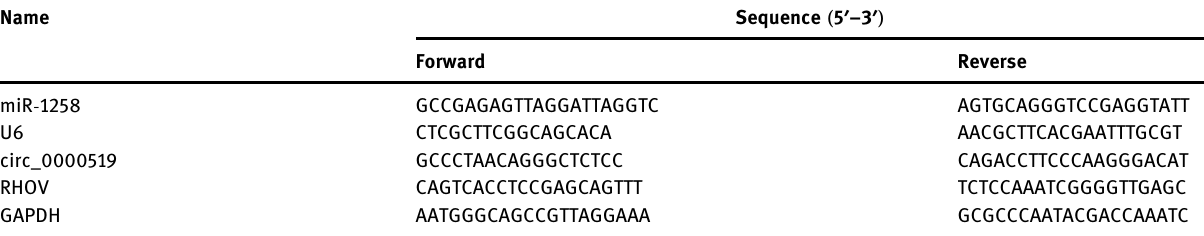
Table 2: The primer sequences for qRT - PCR in this